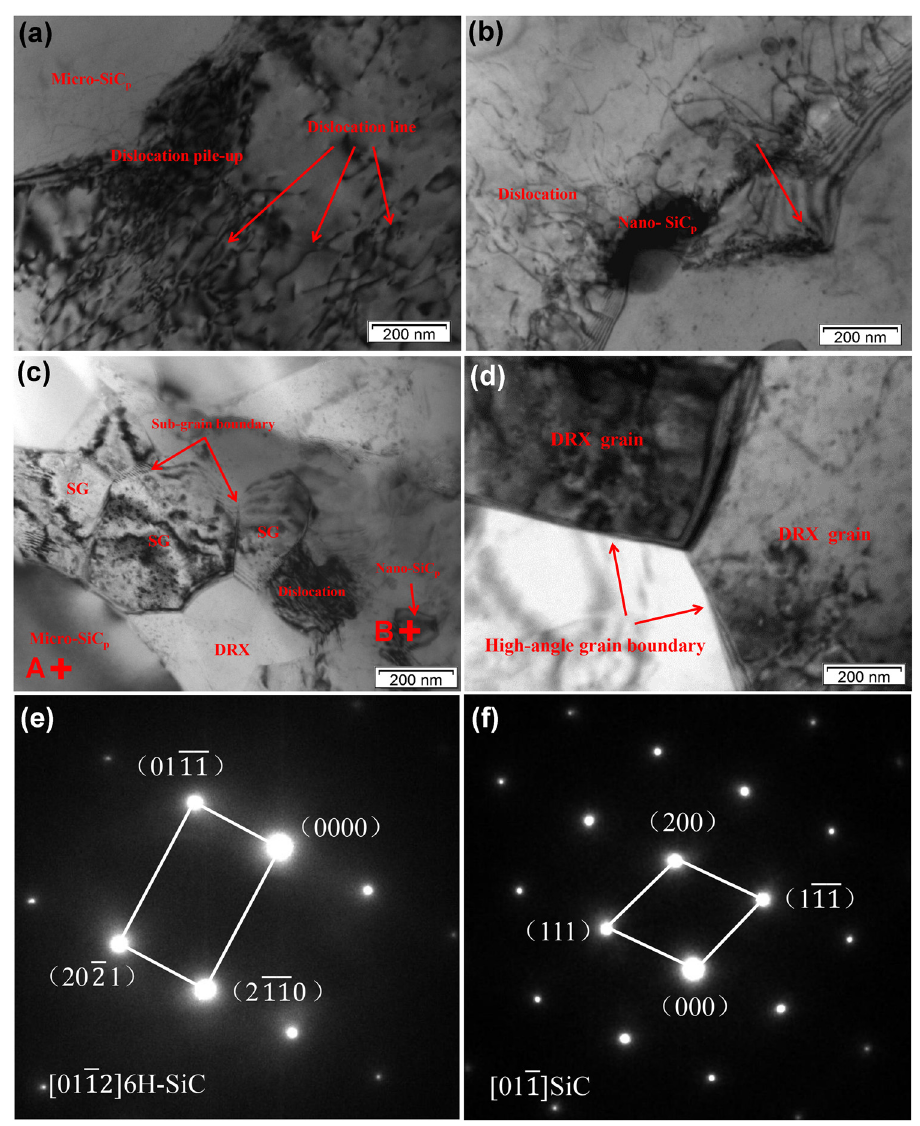
Figure 16: TEM microstructures of the HAMCs at di ff erent strains ( T = 500°C, ε ̇ = 1 s − 1 ) : ( a ) and ( b ) ε = 0.1; ( c ) ε = 0.3; ( d ) ε = 0.5; ( e ) and ( f ) are selected - area electron di ff raction patterns of particles A and B in ( c ) ,